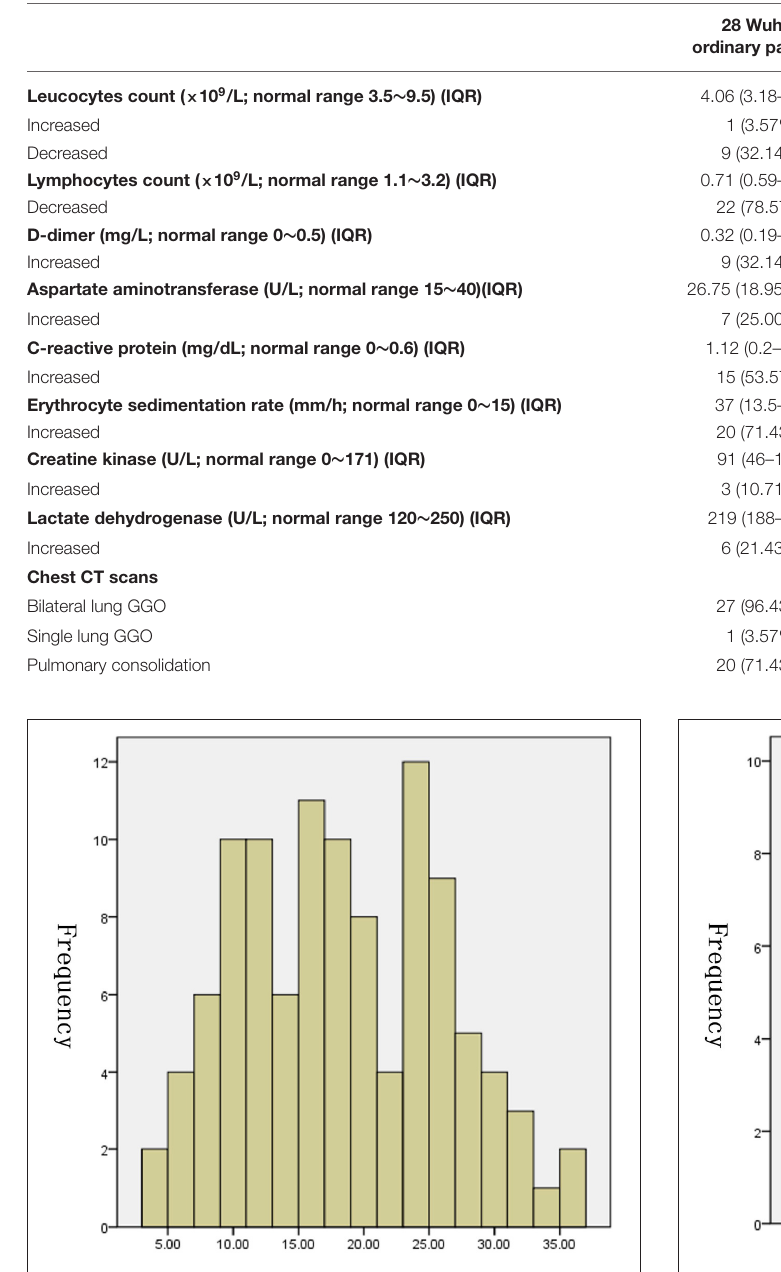
FIGURE 1 | Histogram of the length of hospitalization ( P = 0.035). FIGURE 2 | Histogram of the length of symptoms relief ( P =